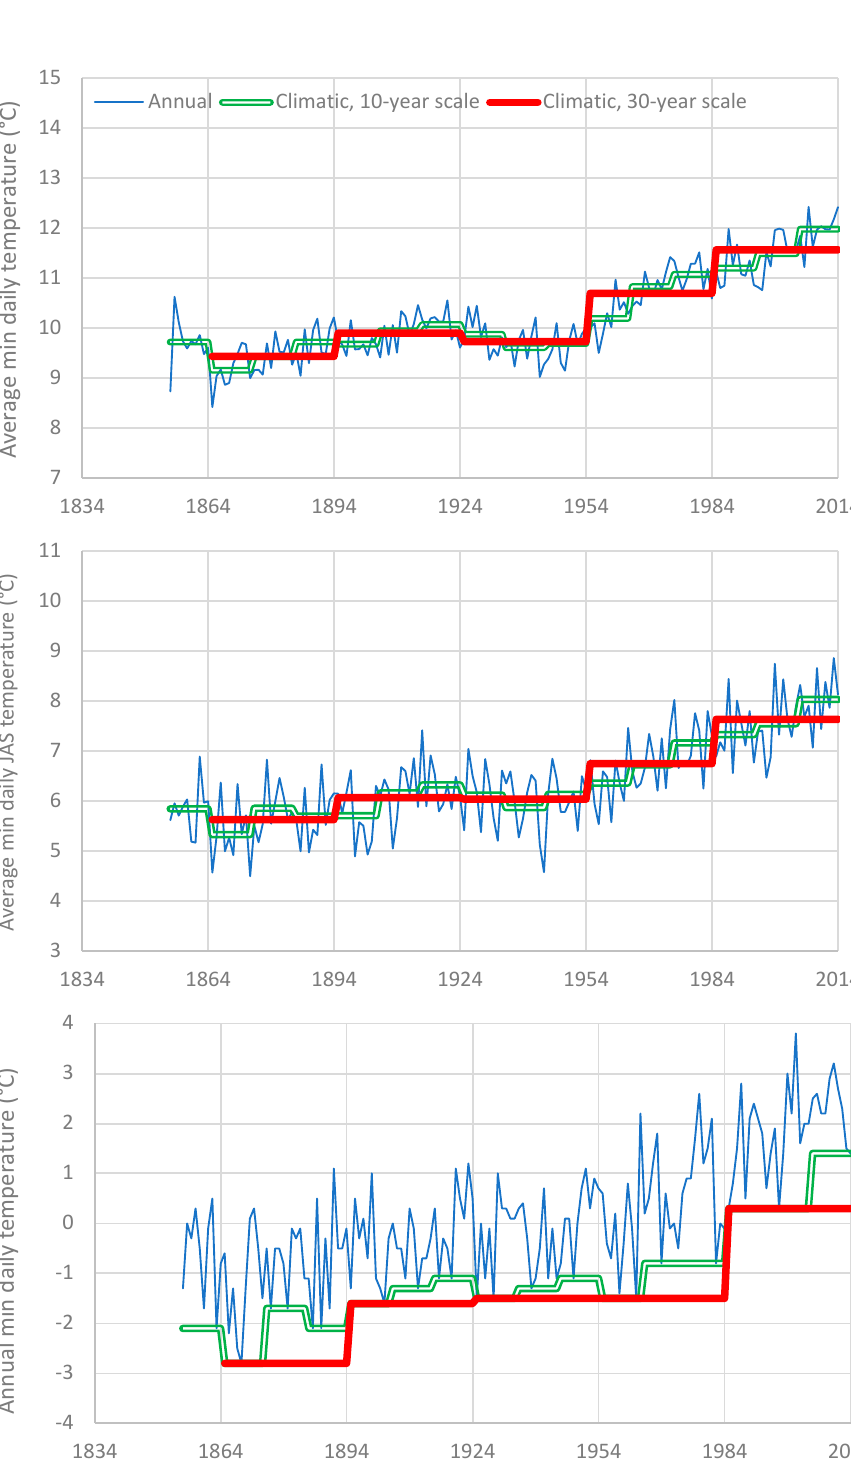
upper panel but for a time window of the three summer months, JAS; ( lower ) as in upper panel but for the annual maximum of maximum daily temperature.